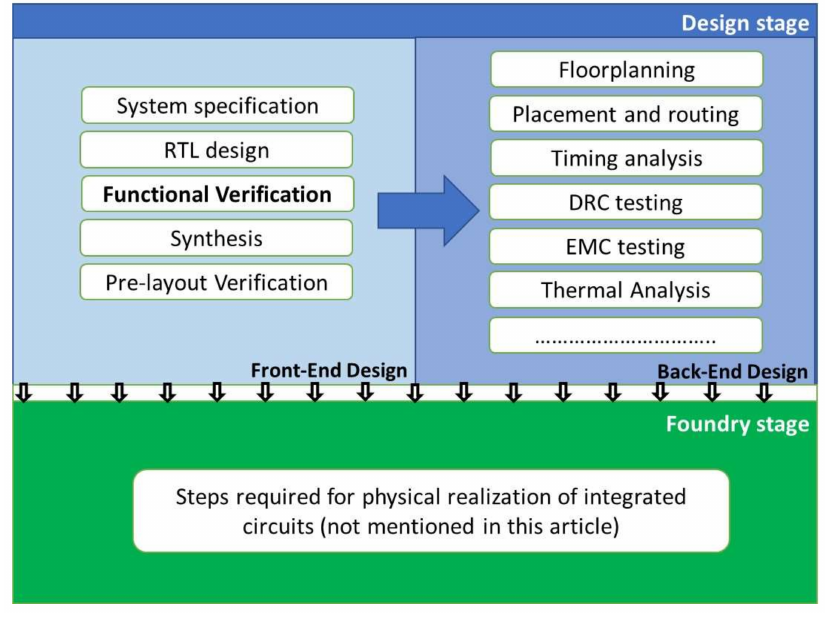
Figure 1. Steps in the manufacturing flow of an integrated